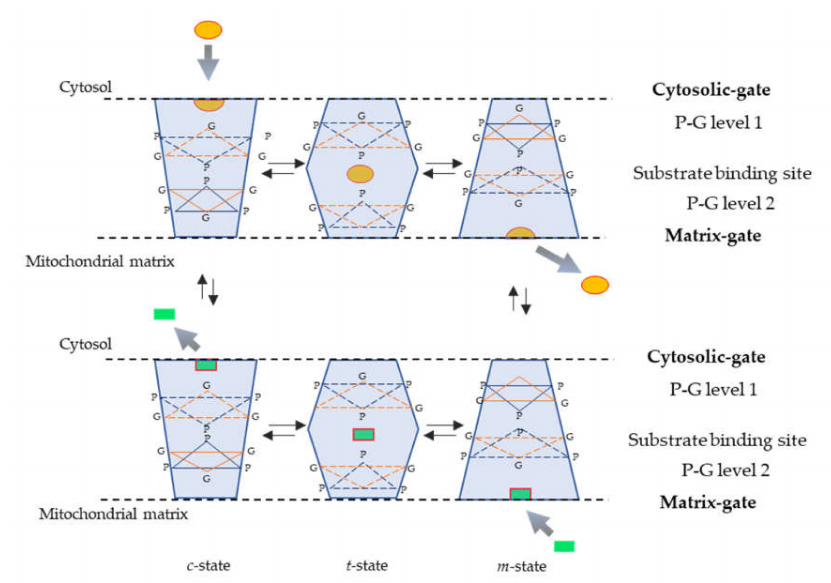
Figure 1. Mechanism of substrate translocation catalyzed by mitochondrial carriers. Simplified scheme depicting the transition of mitochondrial carriers from the c -state to the m -state and vice versa as previously proposed [14]. The trapezoid shape on the left is used to illustrate the c -state after the release of the substrate towards the cytosol and immediately after the entry of the substrate from the cytosolic side; the trapezoid shape on the right illustrates the m -state after the release of the substrate into the matrix and immediately after the entry of the substrate from the matrix side; and the two central hexagonal shape solids depict the transition states ( t -state) of the carrier with the bound substrate entered from the cytosol and from the matrix. The yellow disk and green rectangle shapes represent the substrates entering from the cytosol and from the matrix, respectively; orange triangles represent closed gates, and dotted orange triangles indicate open or partially closed gates. All transport steps are fully reversible. The positions of the salt bridge networks (cytosolic and matrix gates), P-G level 1, substrate binding site and P-G level 2 are indicated on the